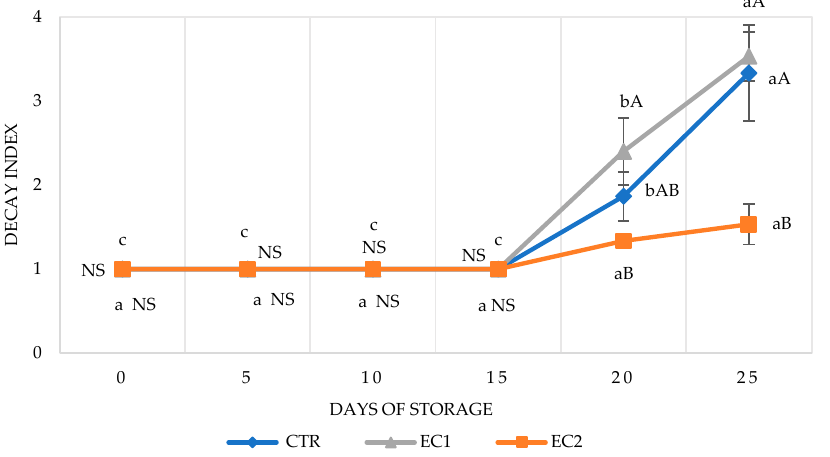
Figure 2. Decay index (D.I.) rated from 1 to 4 on papaya fruit measured for 25 days post-treatment in cold storage 5 ± 1 °C. Values are expressed as mean ± SD. Means with the same letter are not significantly different at p ≤ 0.05 (Tukey’s test). CTR: control fruit; EC1: Aloe arborescens Mill. and essential oil; EC2: only hydrolate. Lowercase letters indicate differences between treatments at the same time of storage; uppercase letters indicate differences between treatments at the same time of storage. NS = non-significant ( p ≤ 0.05).